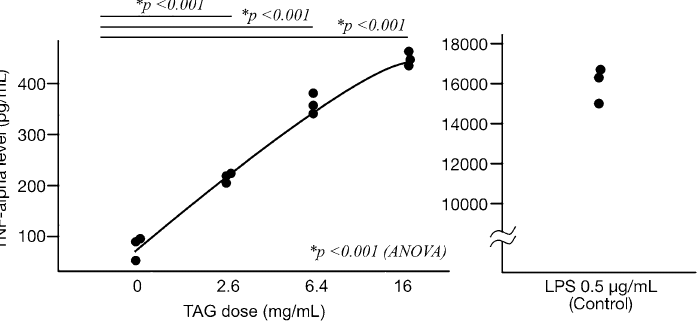
Figure 4. The peanut TAGs induce TNF-α production by mammalian macrophage cells. Left panel. The concentration of TNF-α present in the culture media of RAW264 cells were determined as described in “Materials and Methods”. After 6 h of co-incubation, the peanut TAGs induced TNF-α production by RAW264 cells in a dose-dependent manner. The y-axis represents the TNF-α concentration in the culture media, and the x-axis represents the dose of peanut TAGs added to the cell culture. A result of triplicate experiment is shown in the char (each plot represents one replicate). There was a significant difference across samples in the analysis of variance (ANOVA, p < 0.001), and each of the three doses resulted in statistically significant increases as demonstrated by the post-hoc t -tests ( p < 0.001). Right panel. The concentration of TNF-α present in the culture media of RAW264 cells, when co-incubated with 0.5 μg/mL Lipopolysaccharide (LPS) for 6 h, were determined. The y-axis represents the TNF-α concentration in the culture media. A result of triplicate experiment is shown in the chart (each plot represents one